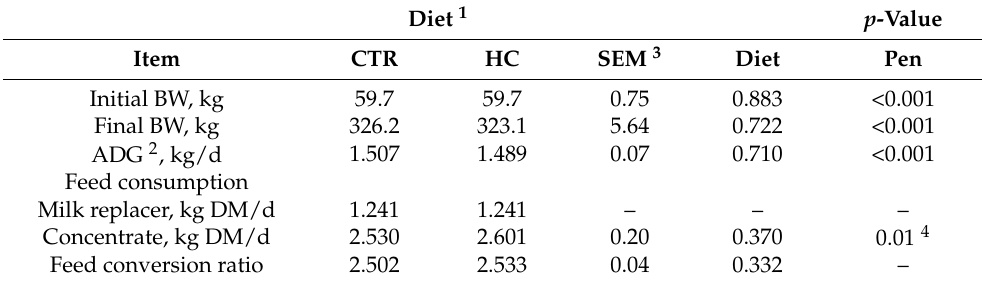
Table 4. Effect of dietary hemp cake inclusion on in-vivo performance of veal calves.